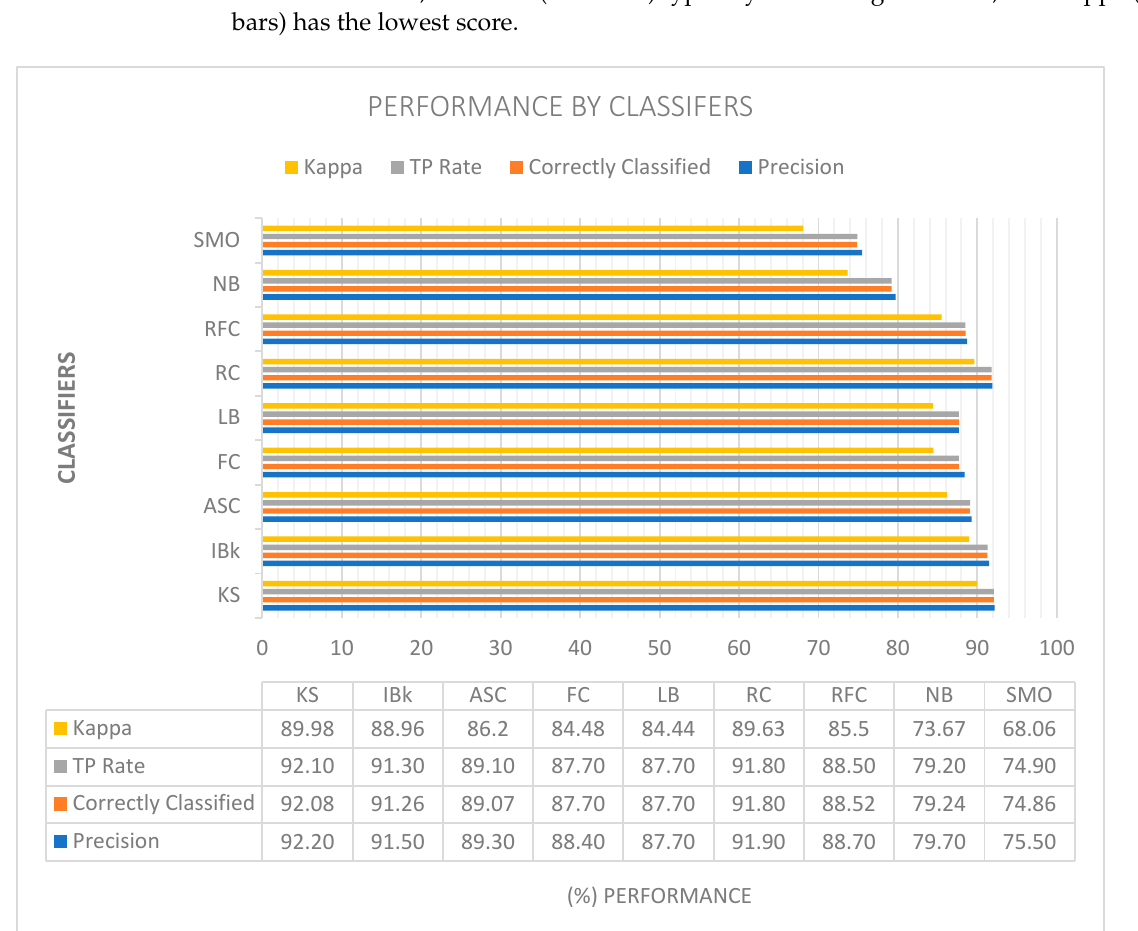
26 of 36 Table 4. Classifier names and their abbreviations. Classifier